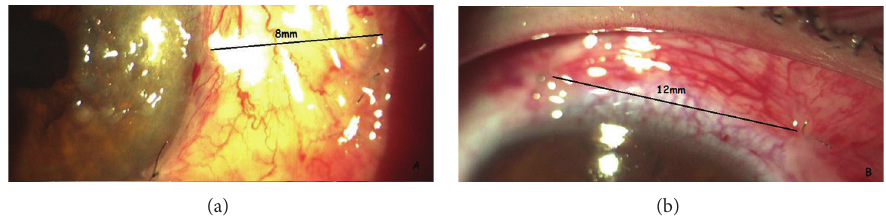
Figure 2: The flap size of conjunctival flap technique; (a) the width of flap is 8mm and (b) the length of flap is 10–12mm.